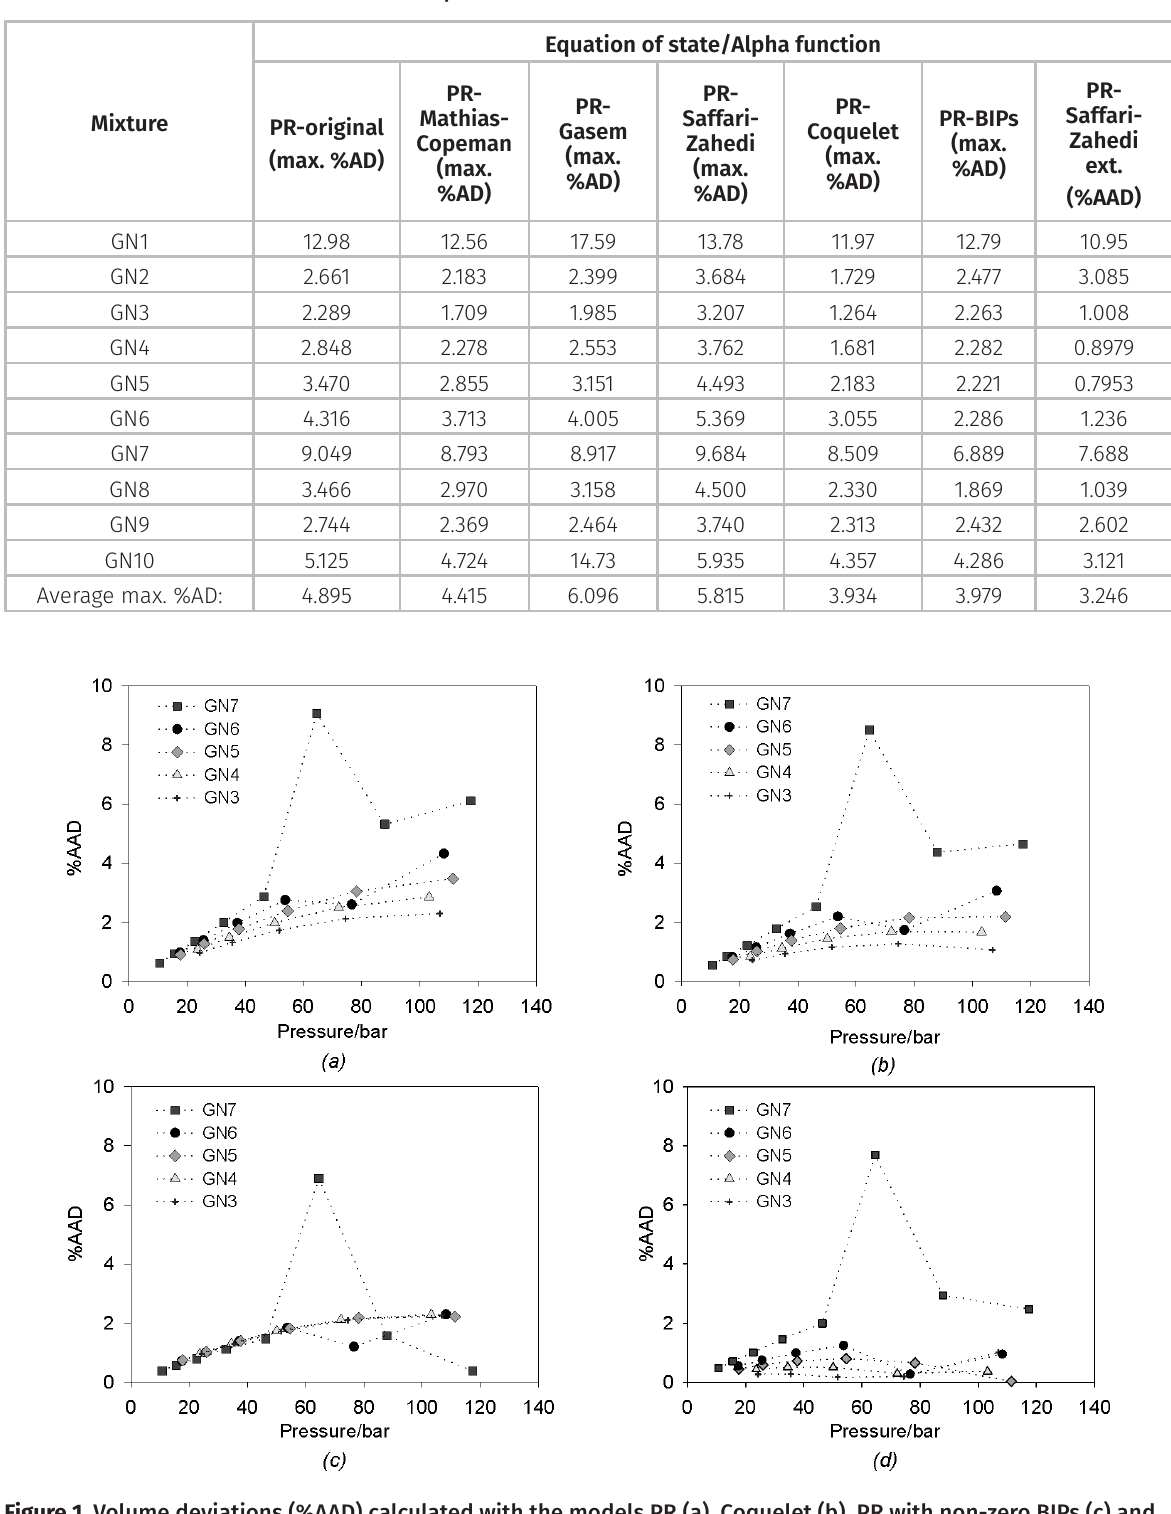
Figure 1. Volume deviations (%AAD) calculated with the models PR (a), Coquelet (b), PR with non-zero BIPs (c) and extended Saffari-Zahedi